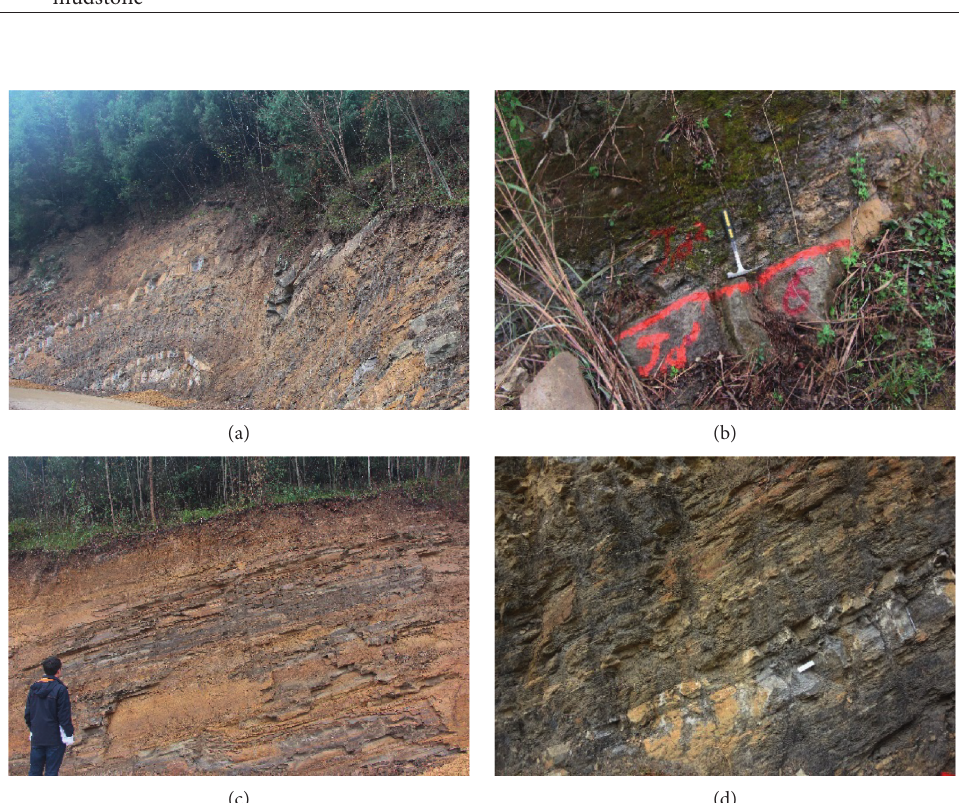
Figure 2: Fine-grained rock lithology and lithological combination of the Da’anzhai Member, Liangping outcrops, Sichuan Basin. (a) Assemblage of limestone at the top of the Da 1 submember and shale at the lower part of the Da 2 submember. (b) At the interface between Da 1 and Da 2 submember, shale and limestone are in contact. (c) Thick-layered shell shale of the Da 2 submember. (d) Assemblage of shell shale and shell limestone, Da 2